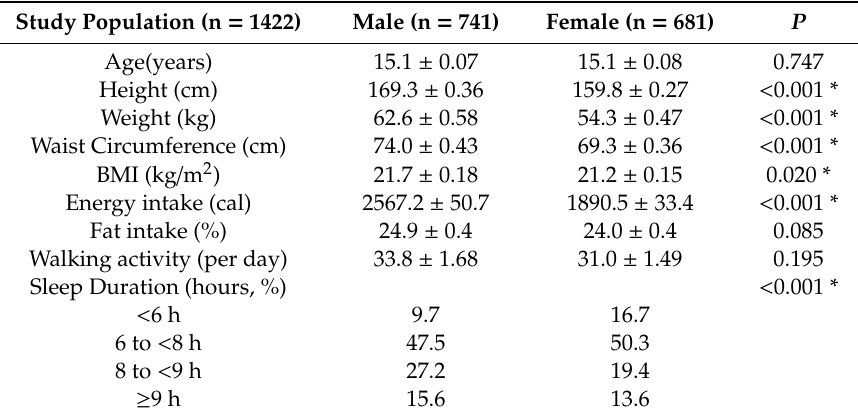
Table 1. Baseline characteristics of study subjects.